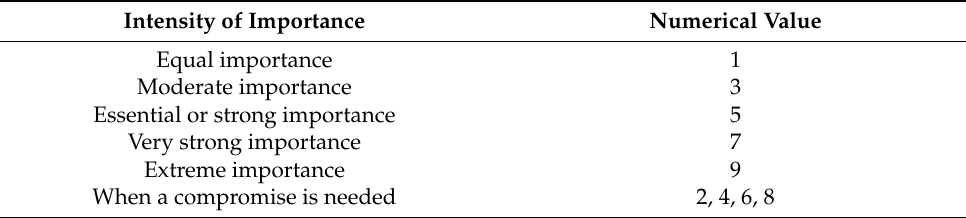
Table 2. The intensity of importance and relative numerical